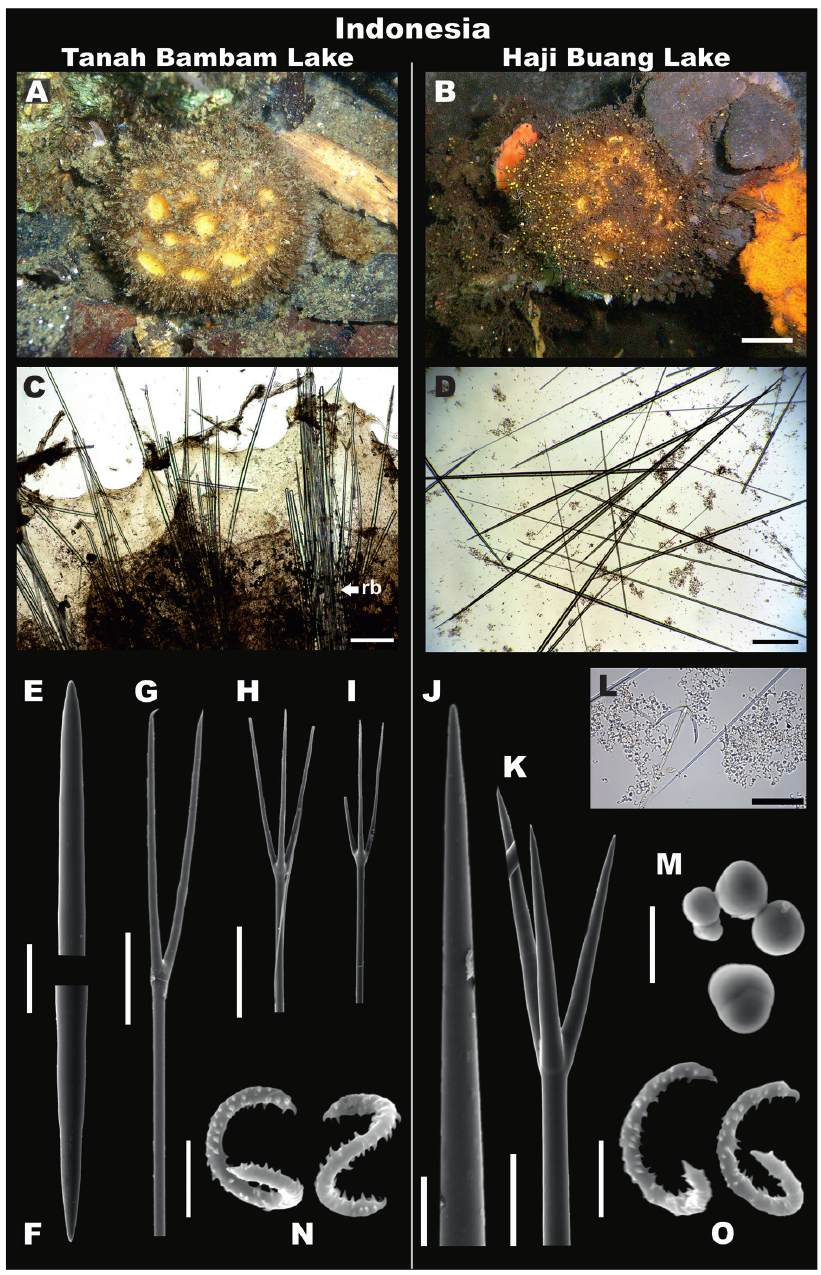
Figure 10. Cinachyrella porosa from Indonesia. A, C, E-I, N, RMNH.POR.11223, Tanah Bambam Lake. B,D, J-M, O RMNH.POR.11235, Haji Buang Lake A-B In situ photographs; C skeleton, showing radial bundles and triaenes D spicules in light microscope showing oxeas and triaenes rhabds E, F oxea, end de- tails G prodiaene H, I protriaene J oxea, end detail K protriaene L anatriaene in light microscopy M spheres N, O sigmaspires. Scale bars: 500 µm ( C, D ); 20 µm ( E,F, J ); 40 µm ( G–I, K ); 100 µm ( L ); 5 µm ( M–O